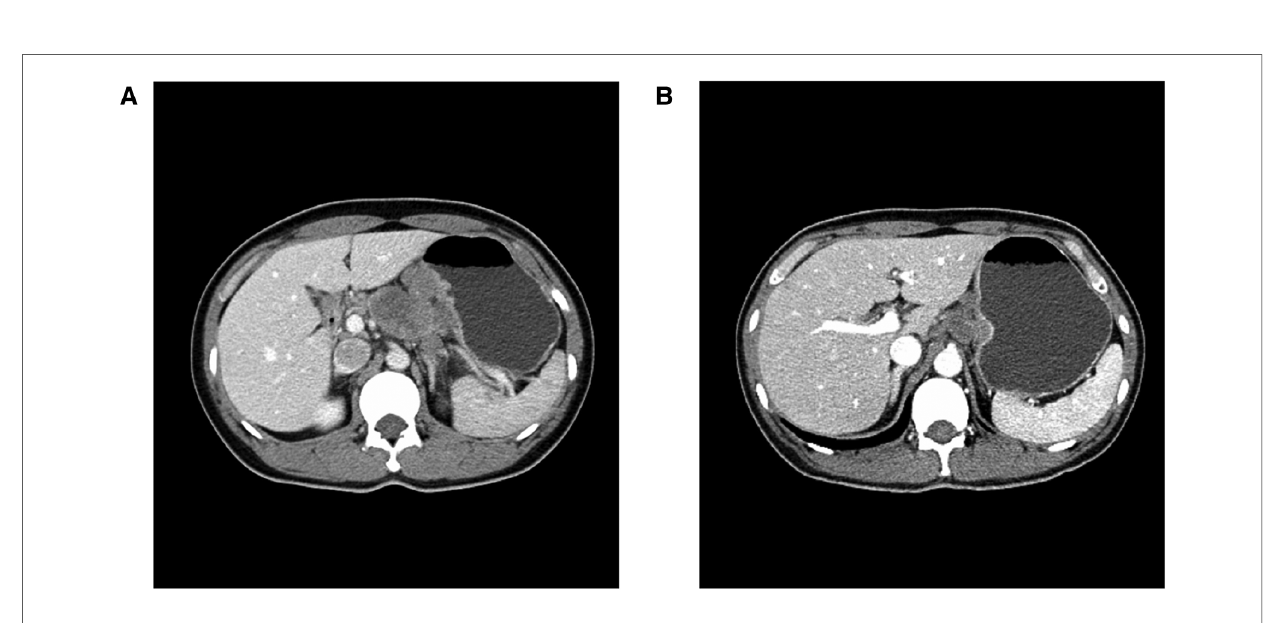
FIGURE 3 Abdominal CT imaging ( A ) Before chemo-immunotherapy; ( B ) After 3 courses of